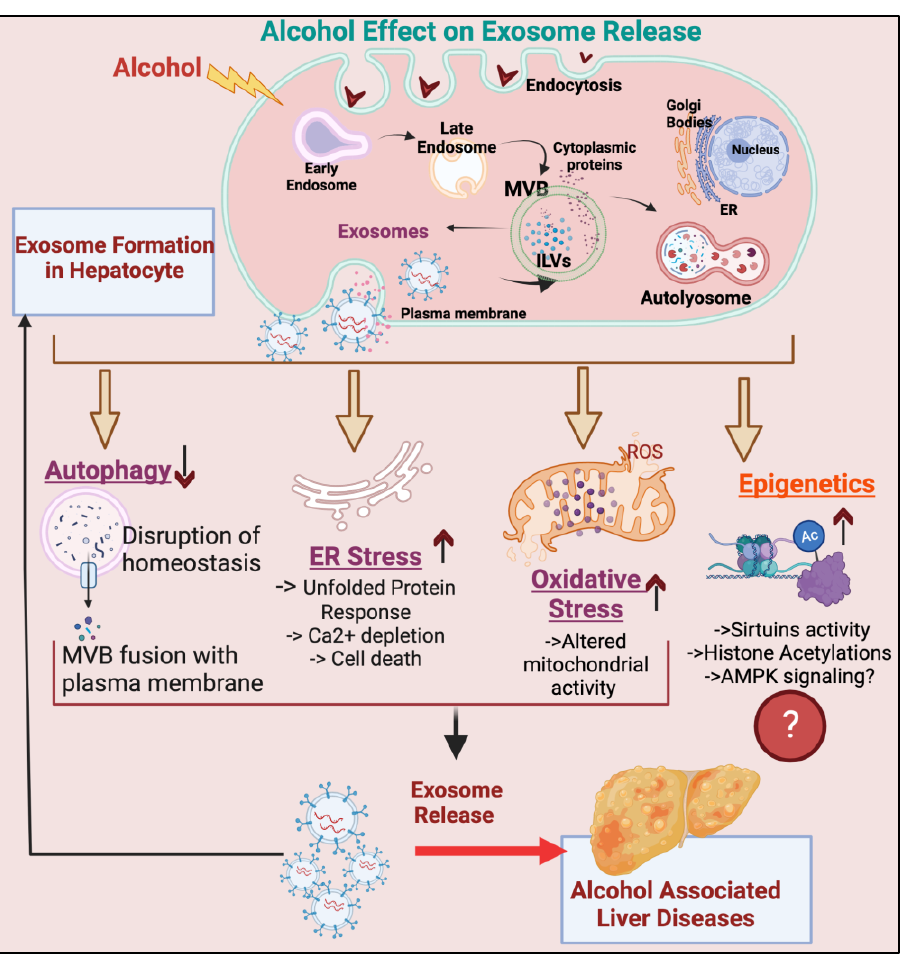
Figure 2. Ethanol promotes exosome release from hepatocytes. Exosomes are nanovesicles that are borne from the intraluminal vesicles of multivesicular bodies (MVBs) and released into fluids of the circulatory system to facilitate cell–cell interactions. Alcohol promotes the release of exosomes from hepatocytes, which are influenced by various cellular processes such as oxidative stress, ER stress, autophagy, and possibly epigenetics. These molecular mechanisms influencing exosome release self-sufficiently cause ALD progression.